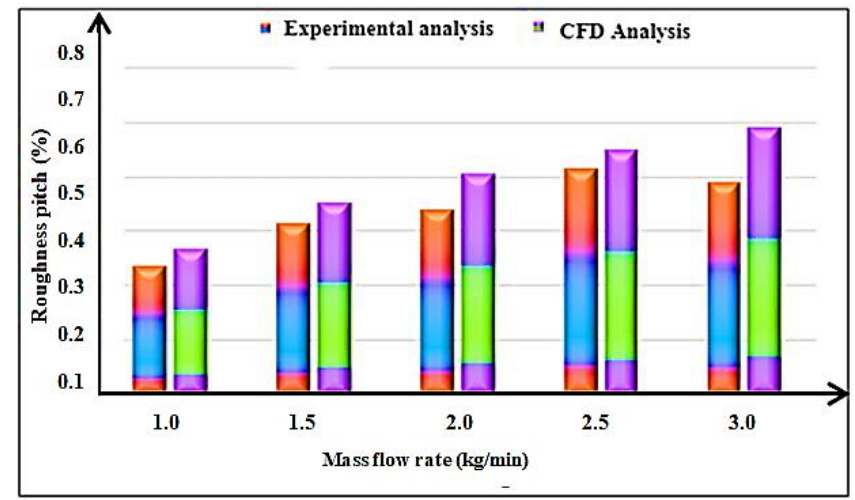
Figure 8. Evaluation of roughness pitch .